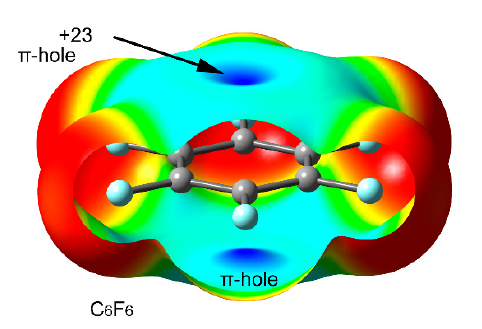
Figure 11. MEP surface of hexafluorobenzene at the B3LYP/6-31+G* (isosurface 0.001 a.u.). The energy value at the π -hole is given in kcal/mol.